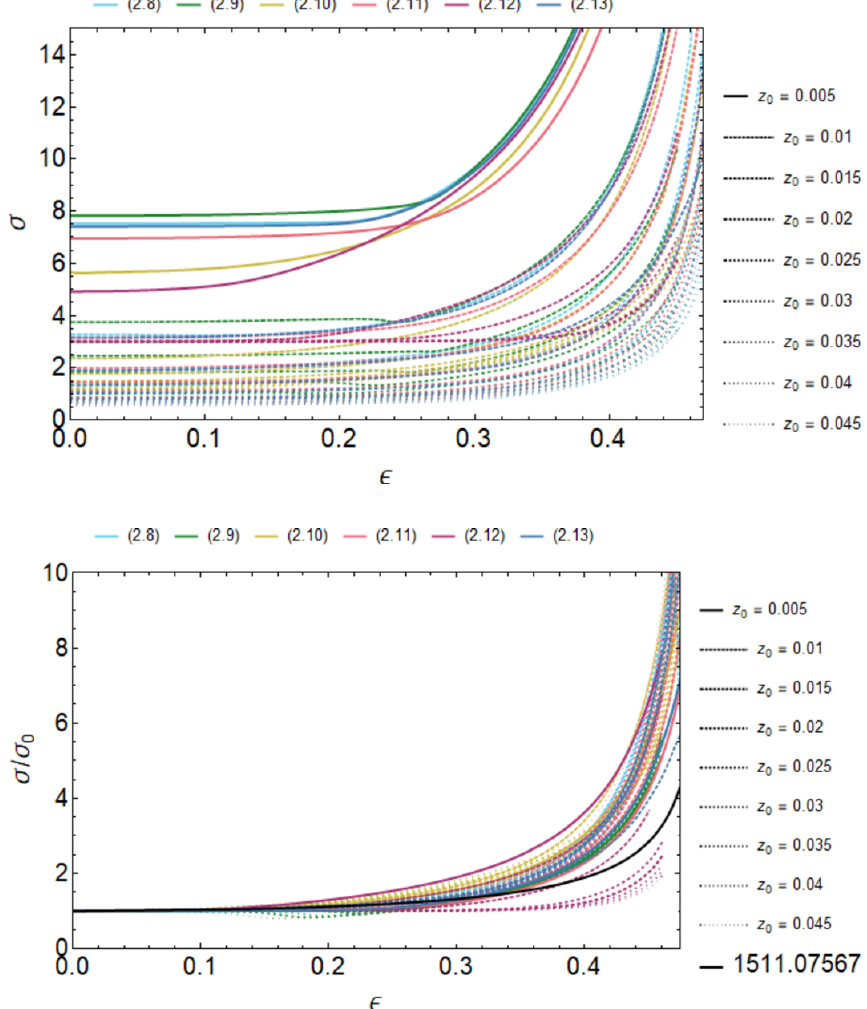
Figure 5 . After nulli(cid:12)cation, the point on the string above which a fraction (cid:15) of the energy of the string is found moves along a null geodesic with some constant downward angle (cid:27) . In the upper panel, we plot this (cid:27) as a function of (cid:15) , after nulli(cid:12)cation, for strings with each of our six classes of initial conditions with varying values of z 0 . Each color represents one of the initial conditions from eqs. (2.8){(2.13) as shown at the top of the plot, and the degree of dashing indicates the value of z 0 used with that initial condition to produce the given curve. (cid:27) 0 is the value of (cid:27) at (cid:15) = 0. In the lower panel, we rescale each of the many curves in the upper panel by its own (cid:27) 0 . We (cid:12)nd that for the strings with the initial conditions (2.8), (2.9), (2.11) and (2.13) in which the initial downward angle of the string endpoint was zero, after nulli(cid:12)cation the rescaled curves in the lower panel all take on a rather similar shape. This means that, for these initial conditions, the nulli(cid:12)cation dynamics rearranges the way that energy density is distributed along the string as a function of (cid:27)=(cid:27) 0 such that it reaches an approximate scaling form. The purple curves show that for initial conditions like (2.12) that are close to null from the beginning, because the energy density distribution along the string hardly changes it need not reach the scaling form.